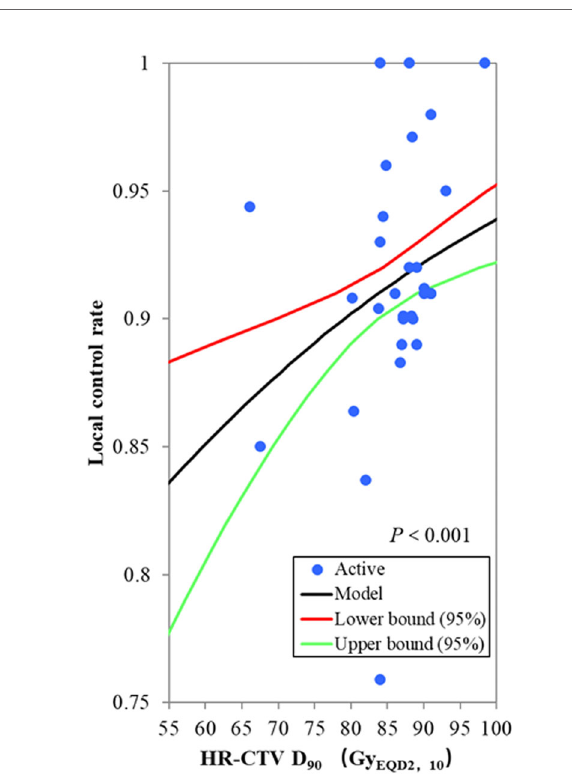
FIGURE 2 | The probit model for the relationship between the IR-CTV D90 and the local control probability. The blue active point represents the values of the HR-CTV D90 and the local control probability for each study. The IR- CTV D90 corresponding to a probability of 90% local control was 66.5 Gy EQD2,10 (95% con fi dence interval: 62.8 – 67.9 Gy EQD2,10 ), p =